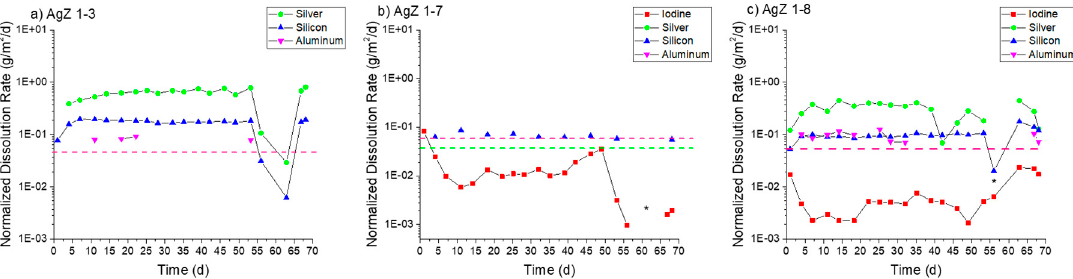
Figure 7. Normalized dissolution rates calculated from SPFT experiments using the AgZ samples at pH 7 for: ( a ) AgZ 1-3 (iodine-free sample); ( b ) AgZ 1-7; and ( c ) AgZ 1-8. The dashed lines, when present, represent the maximum rate for samplings where the analyte concentration was below the detection limit of the instrument and a dissolution rate calculated using the detection limit value. The asterisks (*) mark samplings where the flow rate deviated by >10% from the average flow of the test.